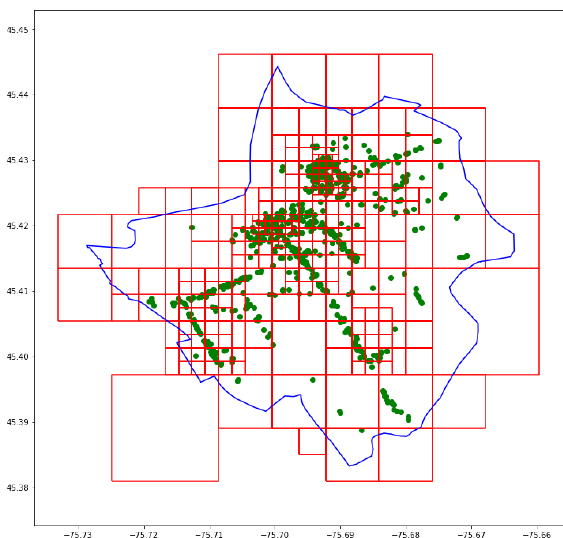
Figure 1. Illustration of the bisection algorithm for keyword “restaurant” in downtown Ottawa. Note: The blue shape is the bounding box of the set of Forward Sortation Area with postal codes K1A, K1N, K1R, K1S, K1P, K2P. The vertical and horizontal axes represent latitude–longitude coordinates. The red squares are those inscribed in the coverage disks of each query, and the green points indicate the businesses found. This data was collected from Google Places in May 2021.